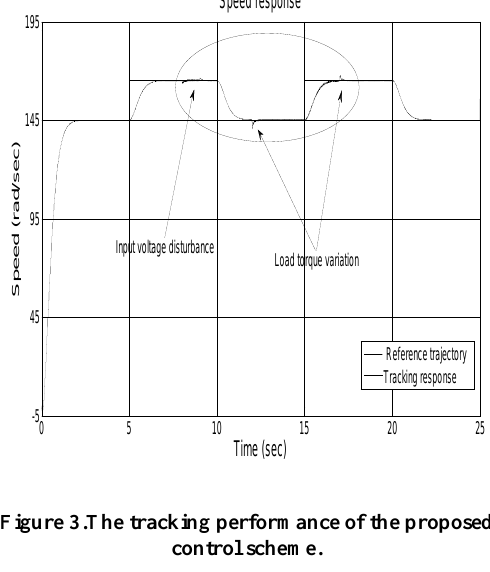
Figure 6. The control effort.